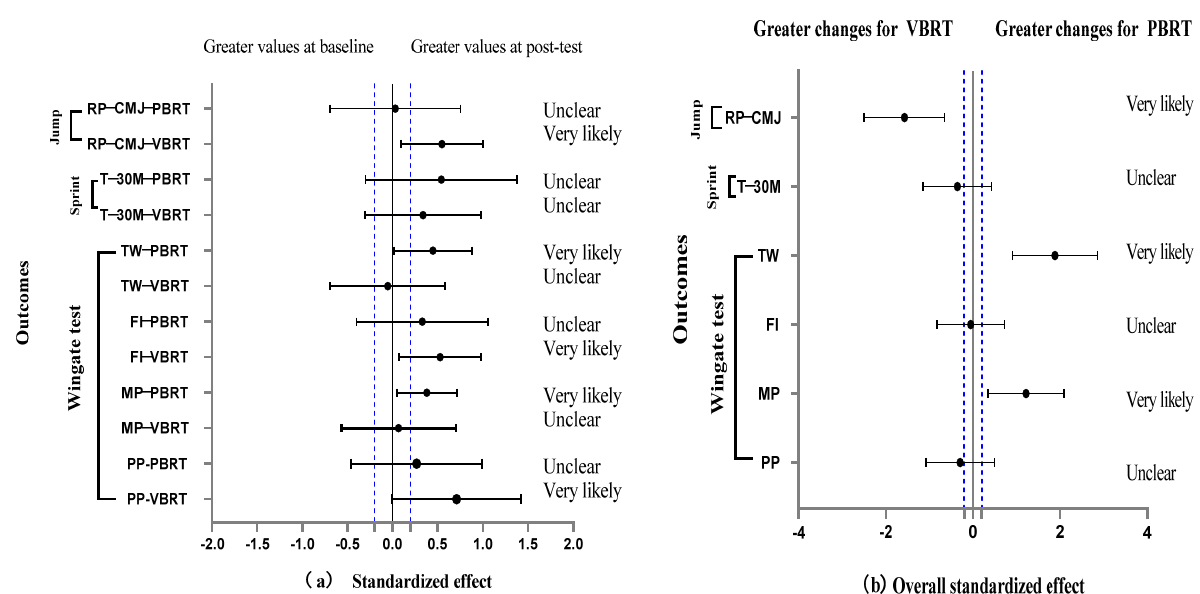
Figure 3. Standardized effect (90%CI) in all outcomes ( a ) between baseline and post − test and ( b ) between VBRT and PBRT groups. RP − CMJ = the relative power of countermovement jump, peak power(W)/body mass(kg); T − 30 m = 30 m sprint running time; TW = total work; PP = peak power output; MP = mean power output; FI = fatigue index for the Wingate anaerobic test.